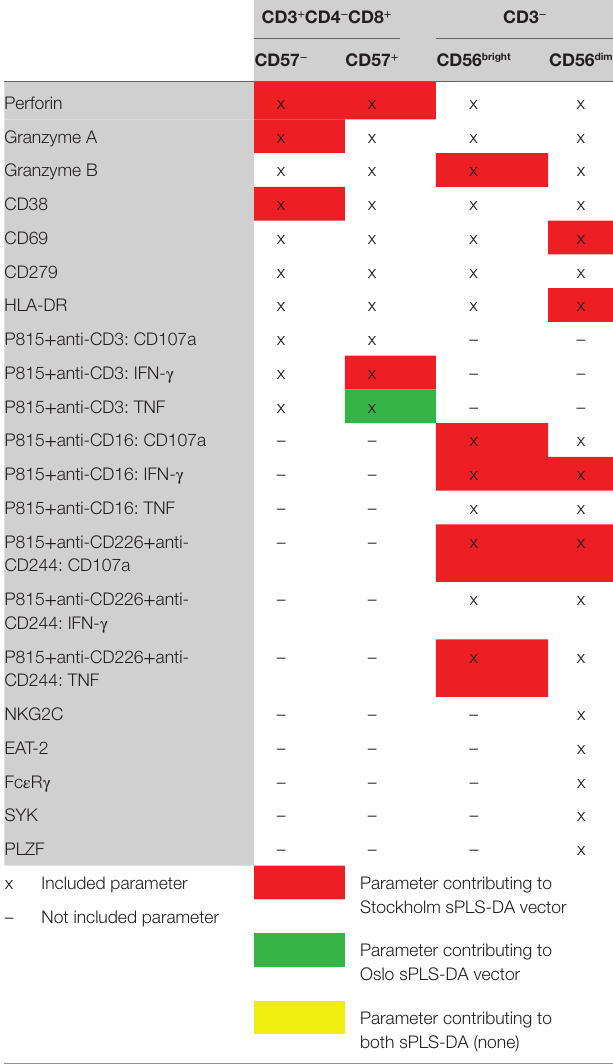
separation of the groups in the Oslo substudy, sparse projection to latent structures discriminant analyses (sPLS-DA) were performed on all 51 common, transformed immunological parameters for the Stockholm and the Oslo substudies separately. sPLS-DA is a supervised method that identifies the vector(s) through a multidimensional data cloud that separates the predefined classes at maximum. By using a penalty for low or absent contribution, variables that contribute to such a discriminant vector are identi- fied (49). As the dataset in this case was structured into two classes (patient or control), models with one discriminant vector were chosen in accordance with previous literature (50). To